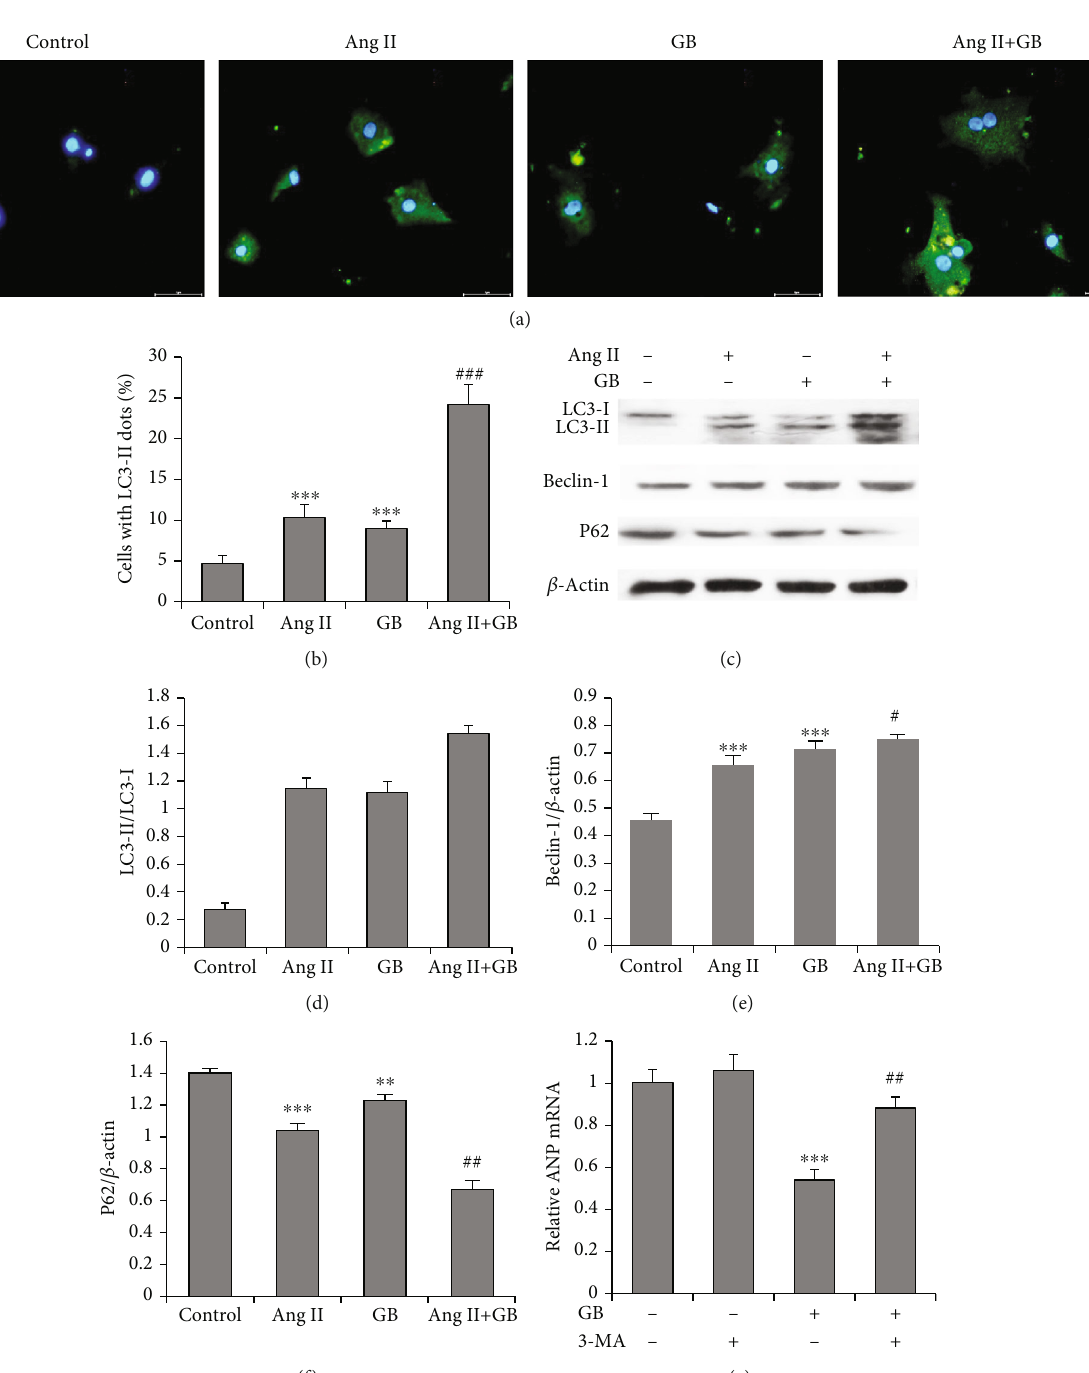
Figure 2: E ff ect of Ginkgolide B on autophagy in Ang II-induced cardiomyocytes. (a) Fluorescence microscopy of H9c2 cells staining with an LC3-II antibody (green, magni fi cation × 100). (b) Quanti fi cation of cells with LC3-II dots. (c) Representative blots of autophagy-related proteins. GB further increases the ratio of LC3-II/LC3-I (d) and Beclin-1 protein expression (e) and decreases the P62 protein (f) in H9c2 cells with Ang II. Cells were pretreated with the autophagy inhibitor, 3-MA (1 μ M). ∗∗ P < 0 : 01 , ∗∗∗ P < 0 : 001 vs. the control group; # P < 0 : 05 , ## P < 0 : 01 , and ### P < 0 : 001 vs. the Ang II group. (g) 3-MA signi fi cantly attenuates Ginkgolide B-induced inhibition in ANP mRNA expression. ∗∗∗ P < 0 : 001 vs. the GB group; ## P < 0 : 01 vs. the 3-MA